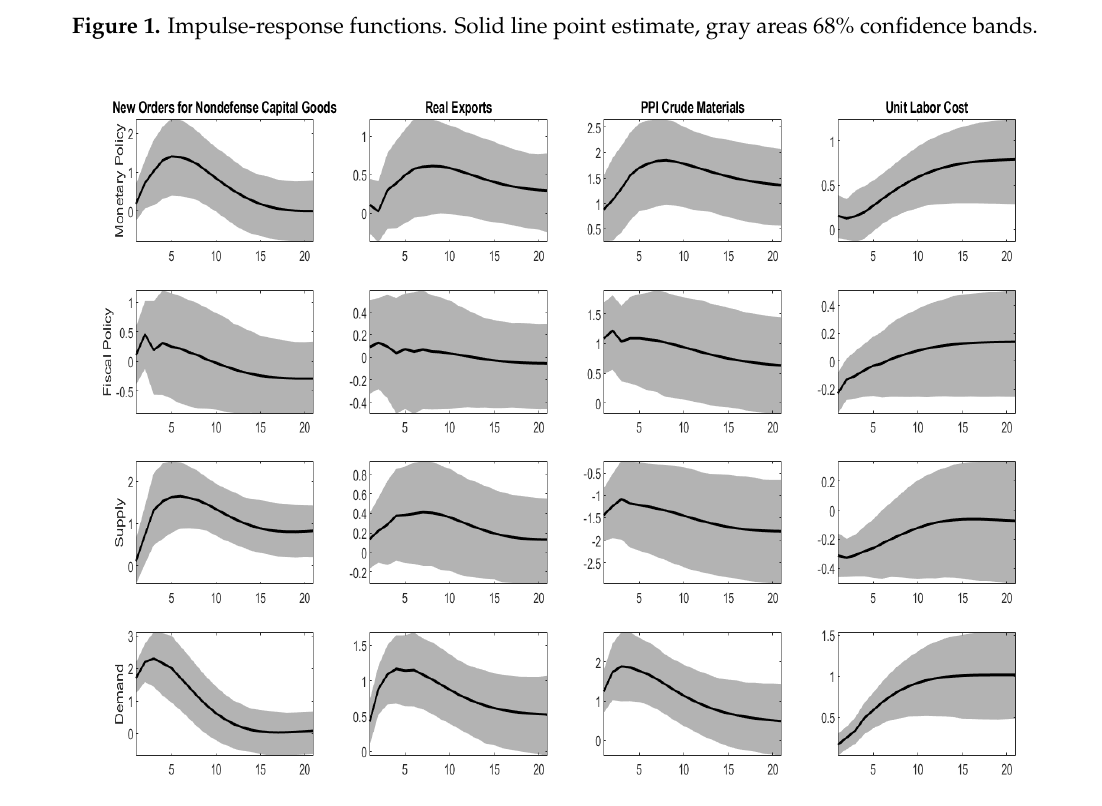
Figure 2. Impulse-response functions. Solid line point estimate, gray areas 68% confidence